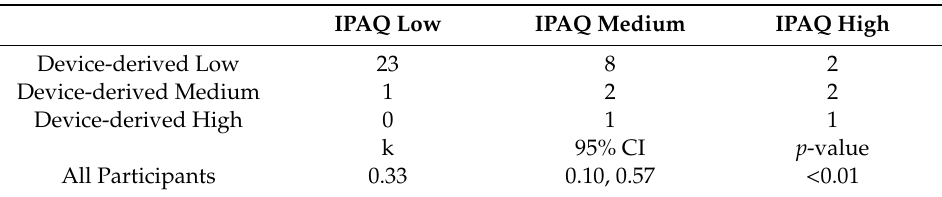
Table 5. Kappa 2 × 2 contingency table (Overall physical activity categories) and Weighted Kappa statistics. IPAQ Low IPAQ Medium IPAQ High Device-derived Low Device-derived